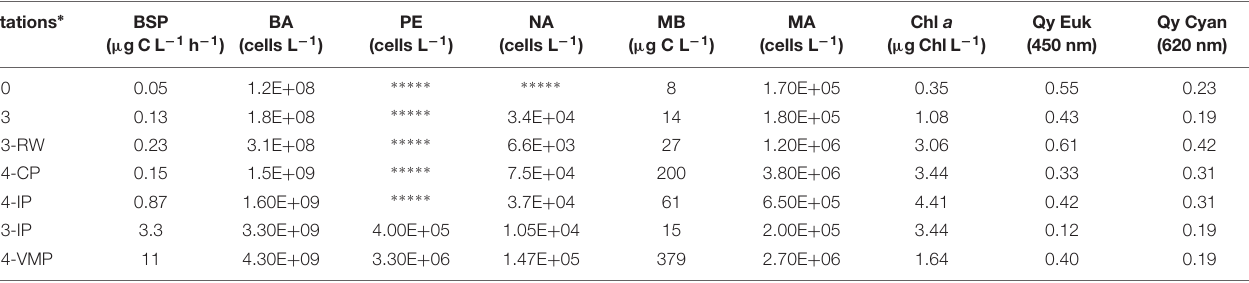
TABLE 2 | Biological characterization of seven stations in Salar de Huasco during November 15, 2013. Stations